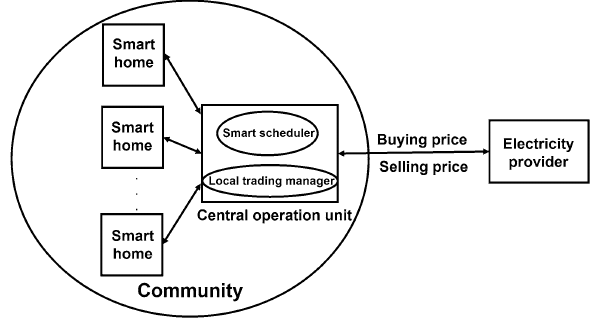
Figure 1. Structure of community energy